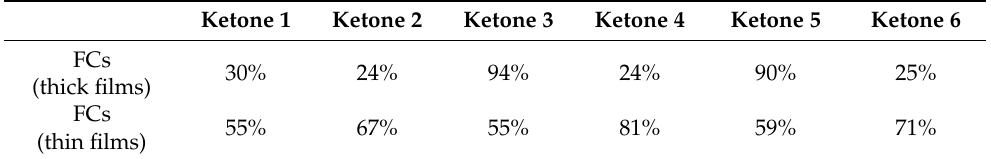
Figure 7. Photochemical mechanism occurring with ketone 3 used as a photosensitizer. Table 2. Final conversions obtained for Ebecryl 40 in thick and thin films using the three-component benzylidene ketones/amine/Iod (0.1%/2%/2%, w / w / w ) system, irradiation at 405 nm with a LED for 400 s. Data extracted from Ref. [234] .